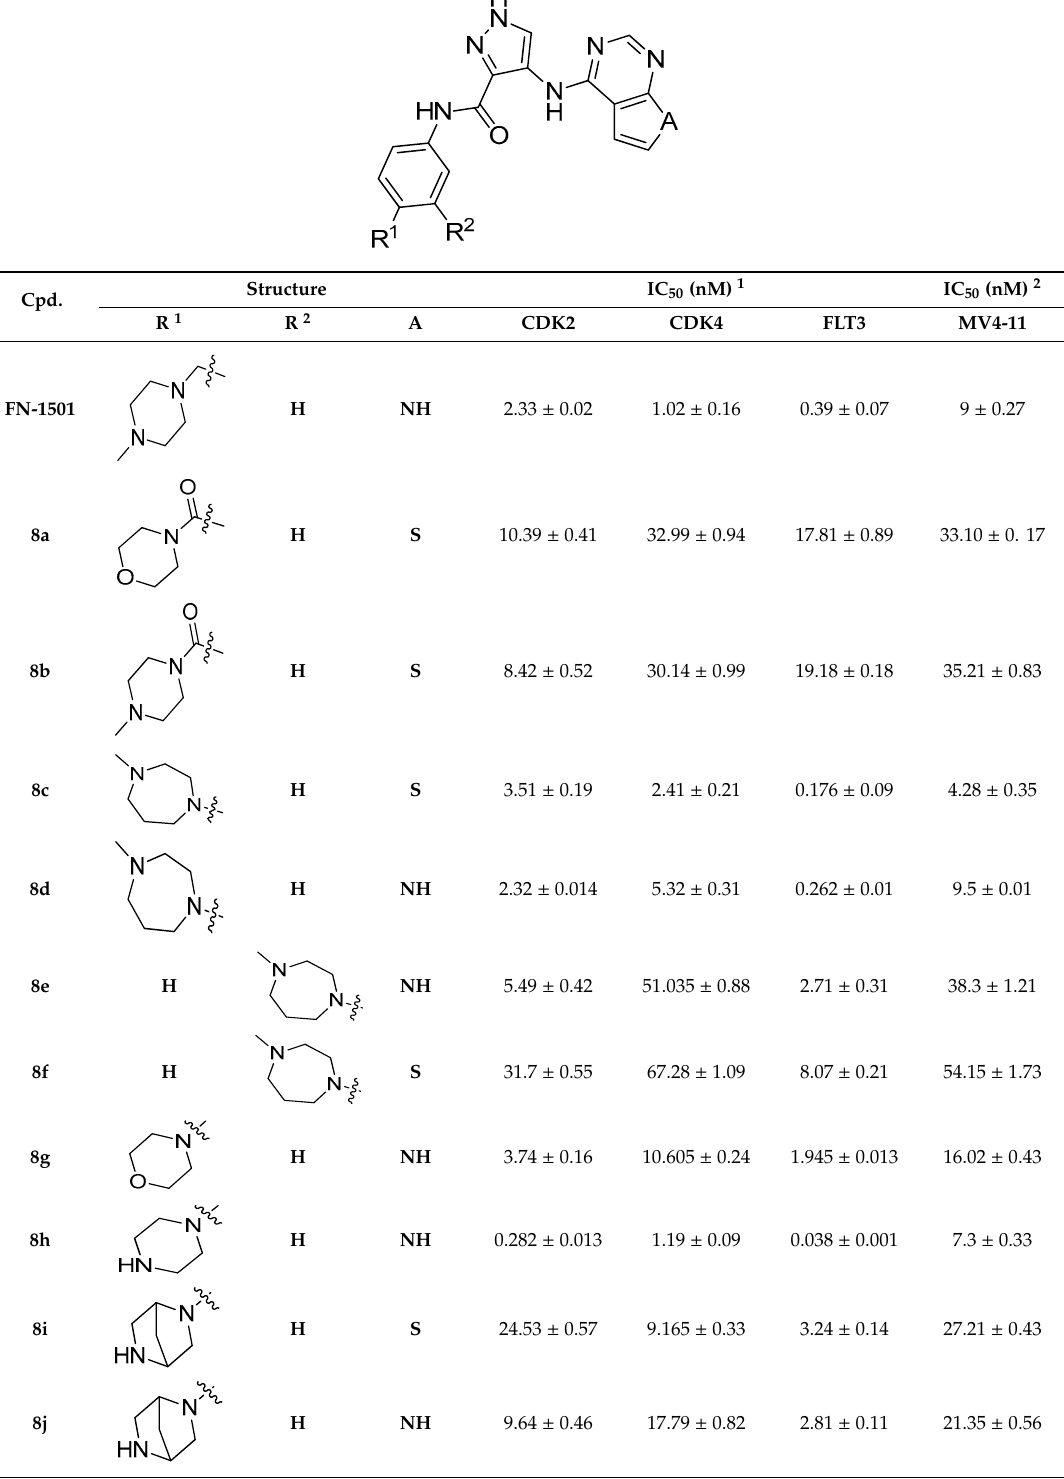
Table 4. Structures and biological activities of compounds 8k – 8t .